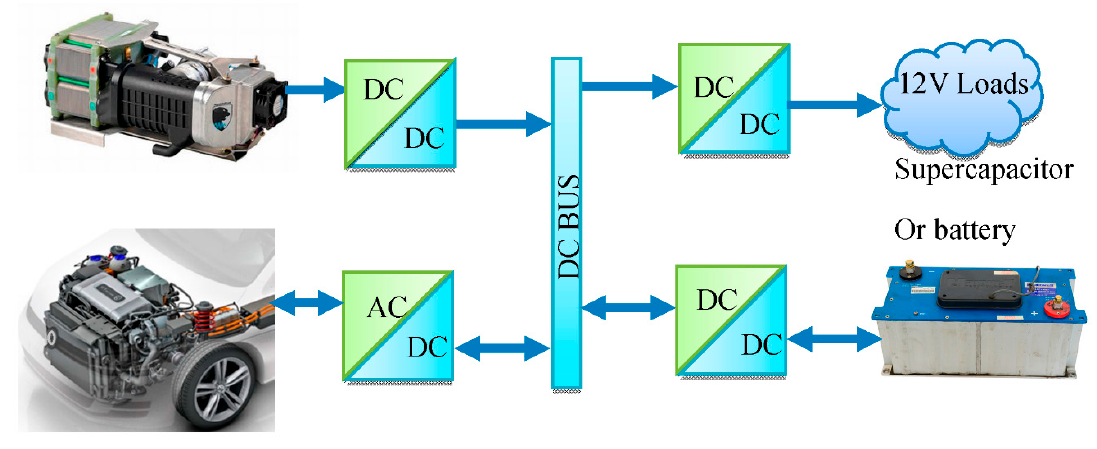
Figure 1. Power train of a hybrid fuel cell vehicle